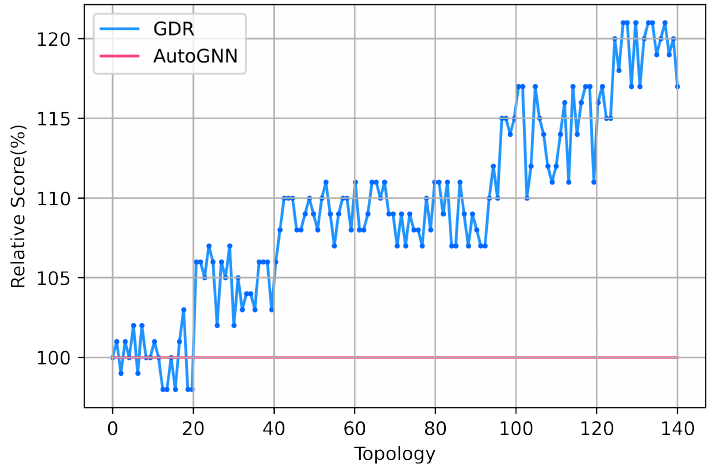
Figure 14. Evaluation of the proposed GDR agent in a dataset with real-world